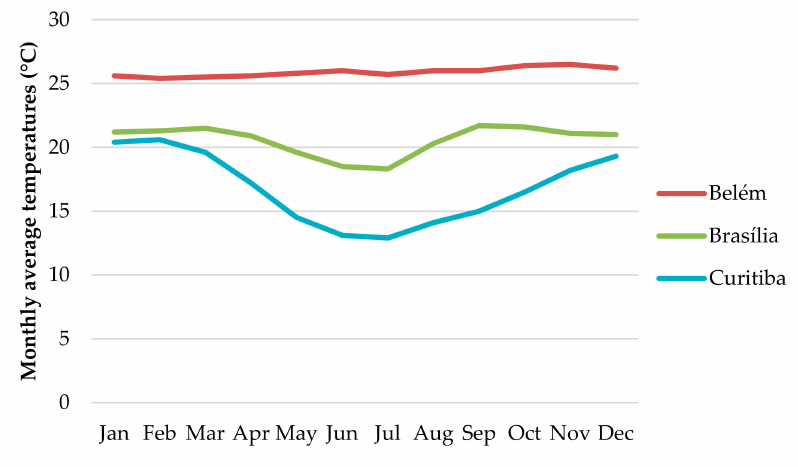
Figure 2. Monthly average temperatures for the three cities. Based on